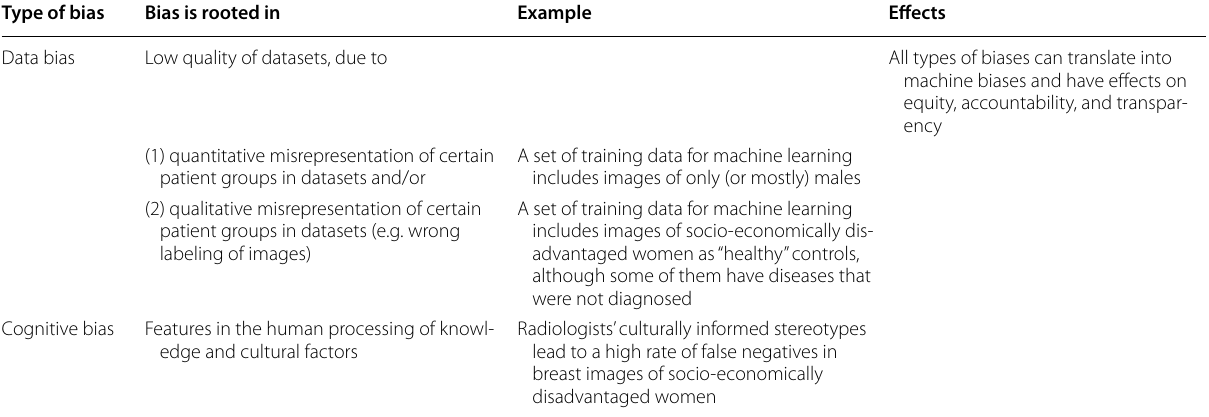
Table 1 Different types of bias in healthcare (authors’ depiction; see also [20, 33]) Type of bias Bias is rooted in